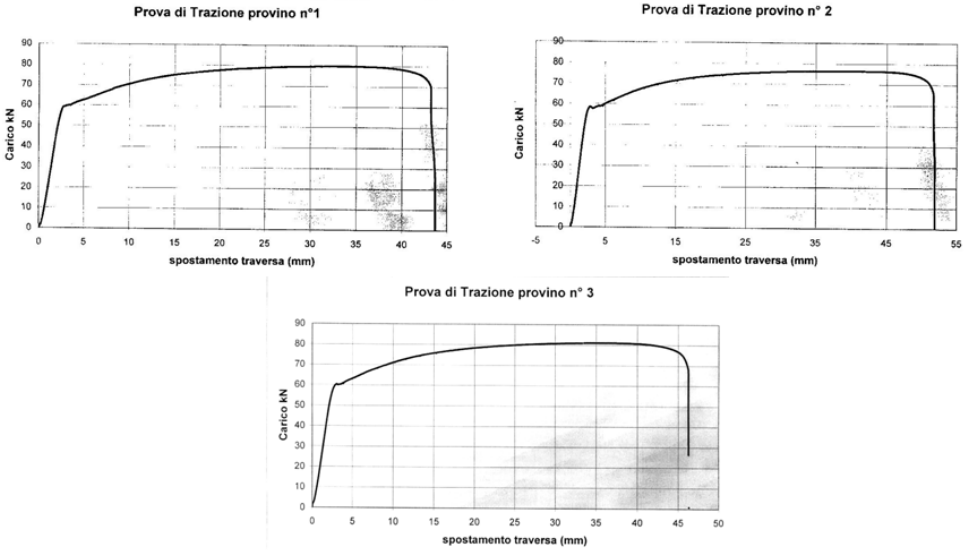
Figura 4: Risultati delle prove di trazione statica.